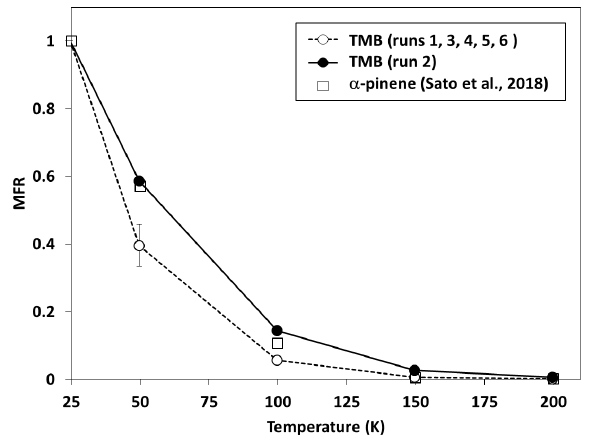
Figure 6. Mass fraction remaining (MFR) for SOA formed from the photooxidation of TMB as a function of thermal denuder tempera- ture (thermogram).